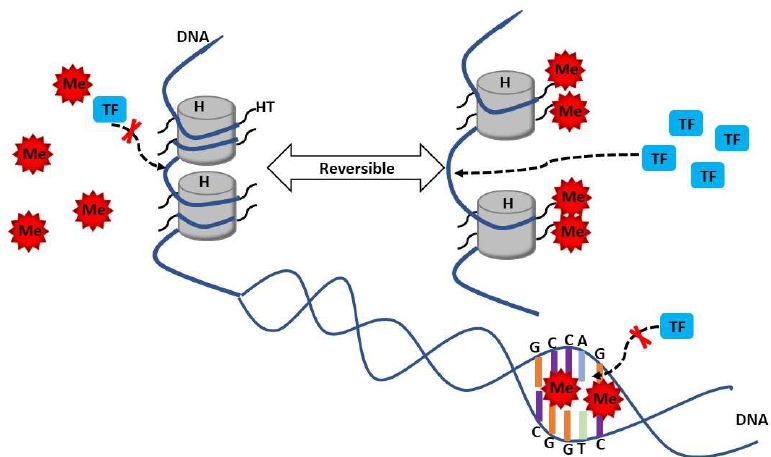
Figure 1. Histone and DNA methylation and demethylation. Histone methylation adds methyl group to the residue of histone tails and increases gene transcription by uncoiling DNA from histone and opening more DNA binding sites to transcriptional factors. DNA methylation happens between paired CG groups in DNA sequences. It prohibits the transcriptional factors binding to DNA and represses the gene transcription. H: Histone; HT: Histone tails; Me: Methylation; TF: Transcriptional factor.